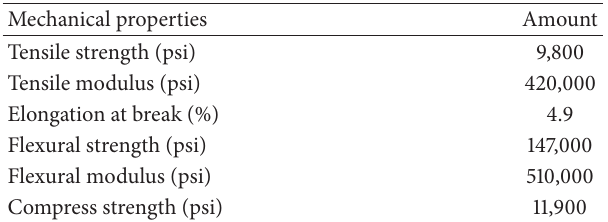
Table 2: Mechanical properties of epoxy BBT